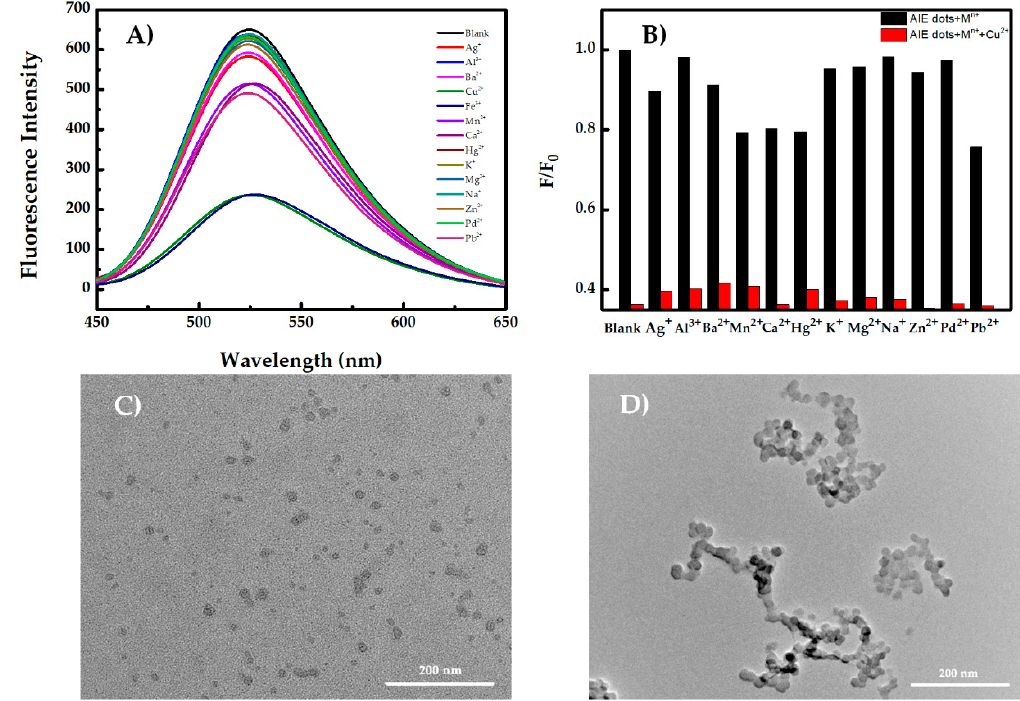
Figure 2. ( A ) Fluorescence spectra of AIE dots in the presence of different metal ions (20 µ M). ( B ) Selective fluorescence responses of the Cu 2+ system in the presence of other metal ions. The black bars represent the emission in the presence of different ions with a concentration of 0.1 mM. The red bars represent the emission in the presence of 20 µ M Cu 2+ and another metal ion with a concentration of 0.1 mM. F 0 and F correspond to the fluorescence intensity at 524 nm in the absence and the presence of Cu 2+ , respectively. ( C ) TEM image of AIE dots. ( D ) TEM image of AIE dots with Cu 2+ (20 µ M).